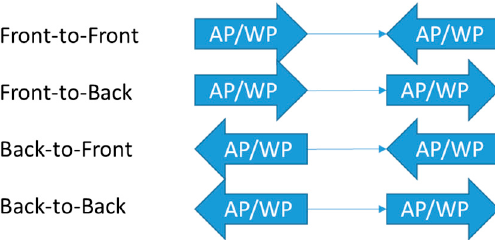
Figure 4. Types of connection between AP and WP.